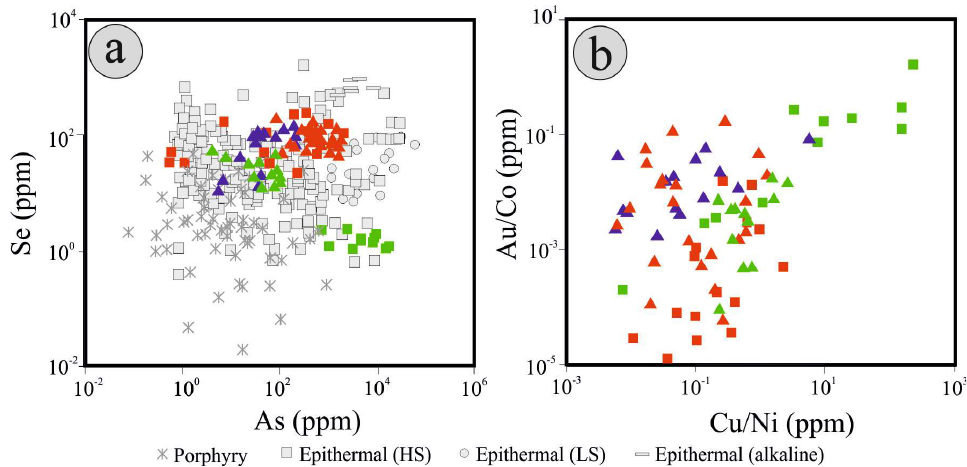
Figure 12. ( a ) Variation of As versus Se in pyrite from the present study compared to pyrites from orogenic Au, Carlin-type, high-sulfidation (HS) epithermal, low-sulfidation (LS) epithermal, alkaline rock-hosted epithermal and porphyry Cu deposits (grey symbols). Adopted from Keith et al. [10]; ( b ) Cu/Ni versus Au/Co plot for various pyrite generations from the studied porphyry/epithermal prospects (adopted from Alford et al. [33]. Symbols as in Figure 8.